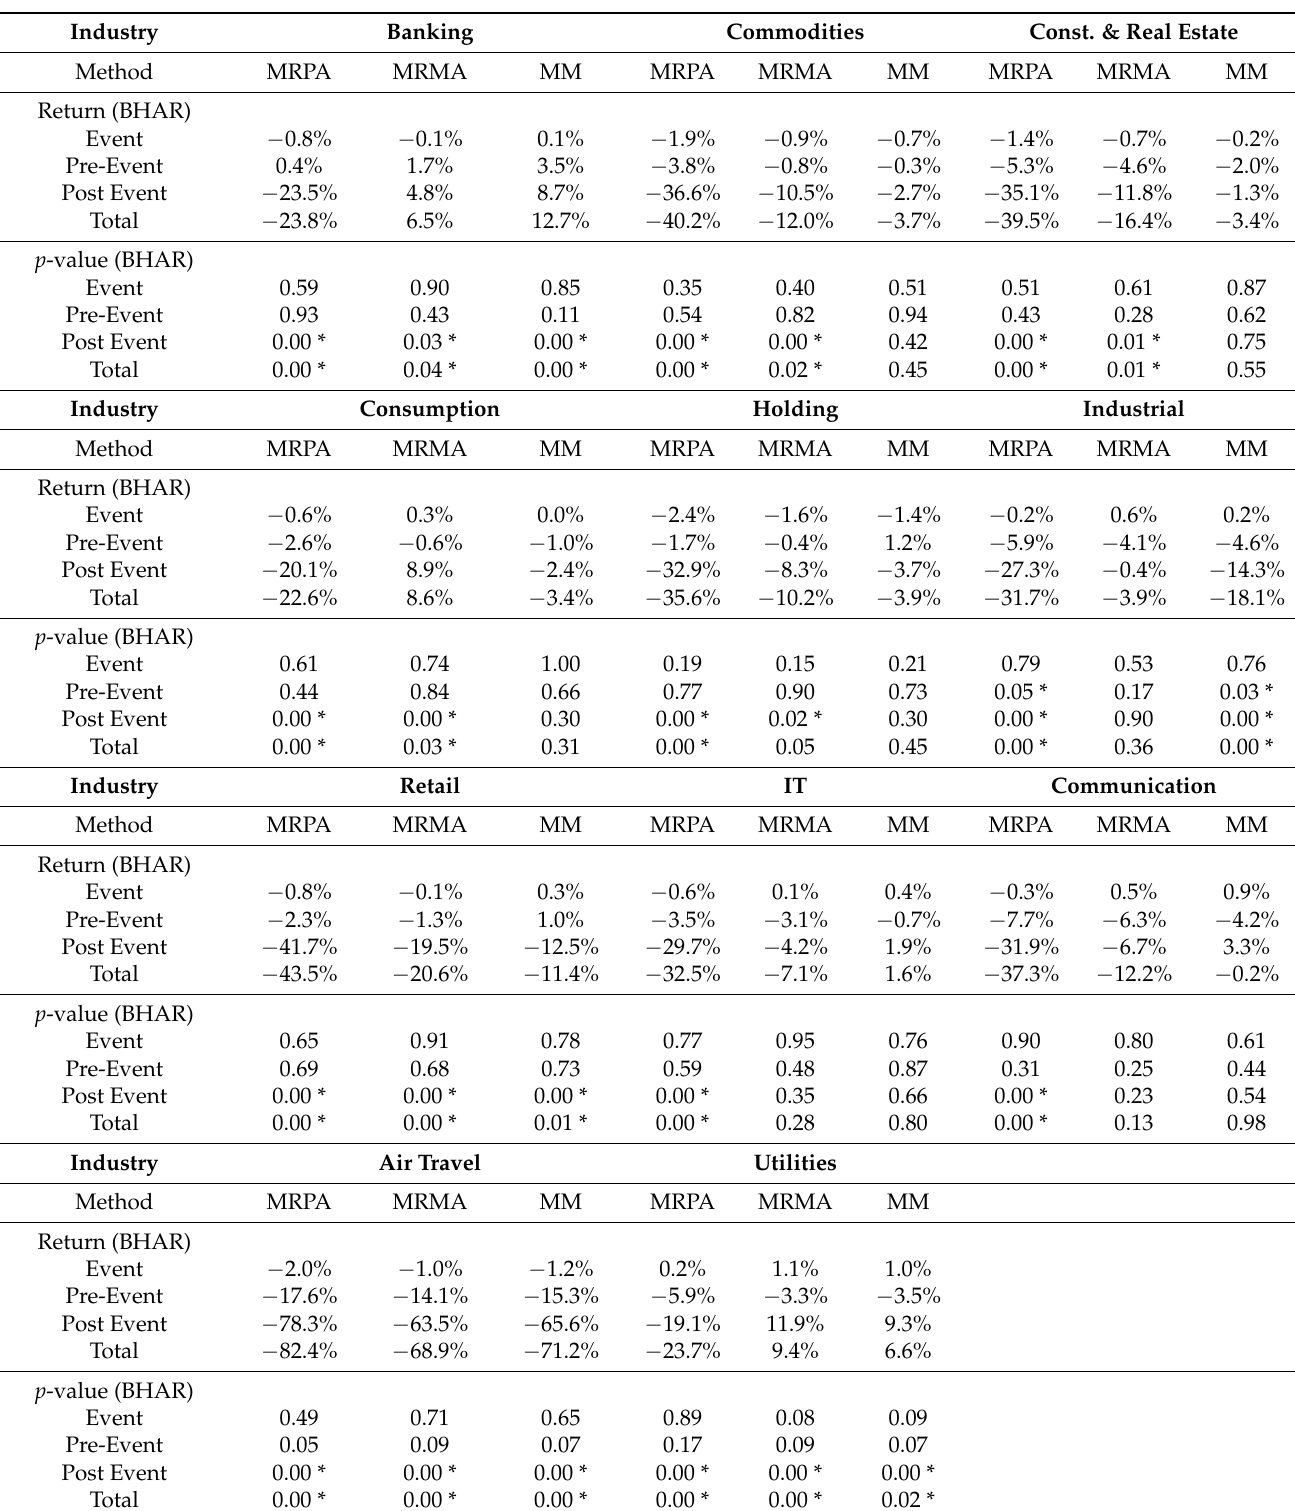
Table 10. BHAR results showing the average of the returns before, during, and after the event with their statistical